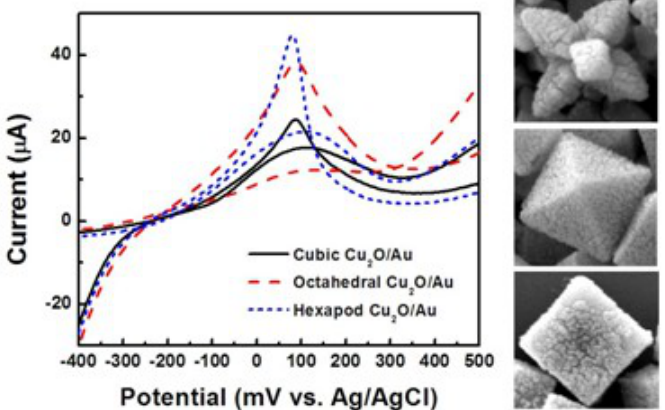
Figure 11. Cyclic voltammograms of electrodes coated with Au decorated cubic, octahedral, and hexapod Cu O in 0.5 M NaOH solution in the presence of 10 mM glucose 2 and corresponding SEM images of the particles.